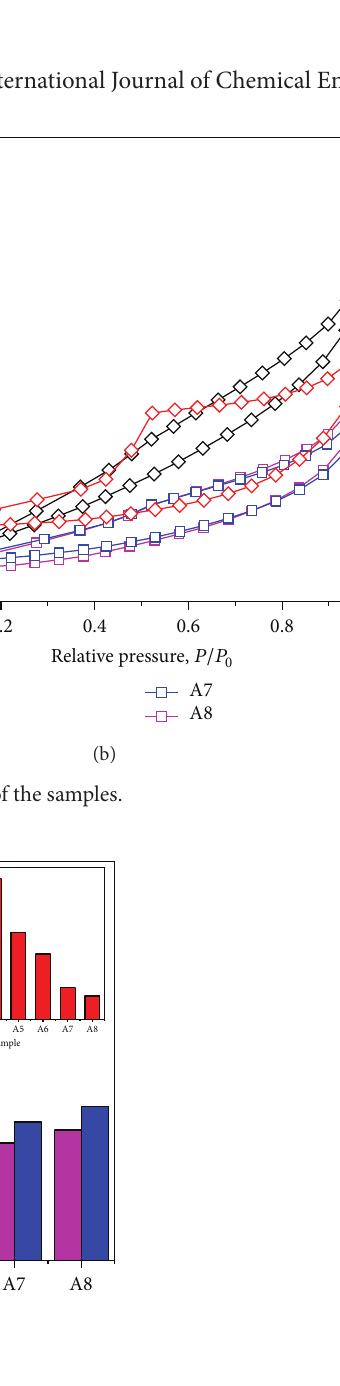
Figure 2: Pore structures of the samples determined by N 2 adsorption/desorption isotherms. SSA was calculated by BET method, 𝑉 determined by NLDFT method, and 𝑉 𝑡 represented the single point total pore volume at 𝑃/𝑃 𝑜 ≈ 0.99